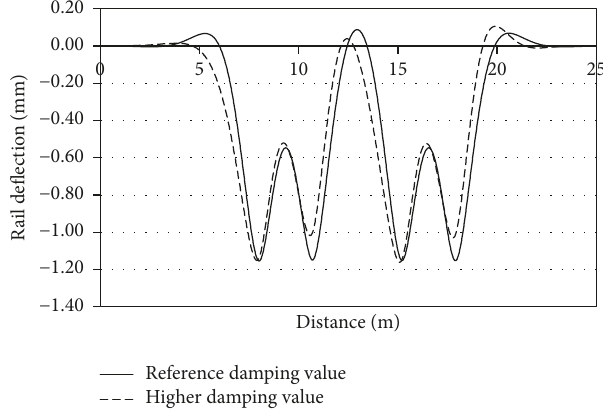
Figure 2: Deflection line of rail modelled by the Euler-Bernoulli beam and various damping properties of rail